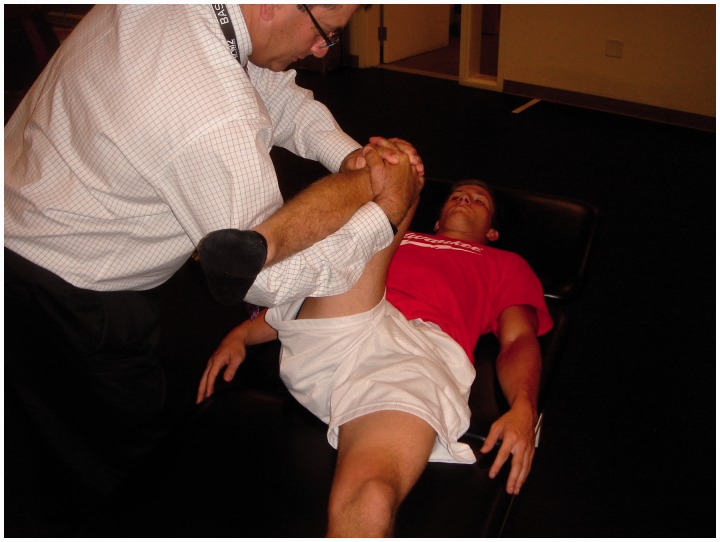
Posterior apprehension test. With the patient supine, the examiner flexes the hip to 90°, adducts, internally rotates and then applies a posterior force on the knee. This will cause posterior pain or sensation of instability.